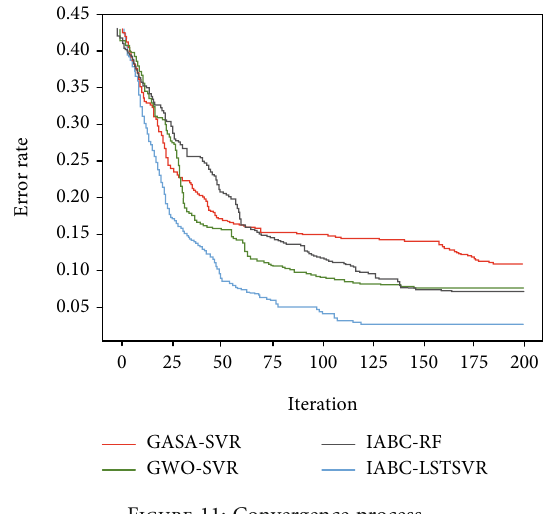
Figure 11: Convergence